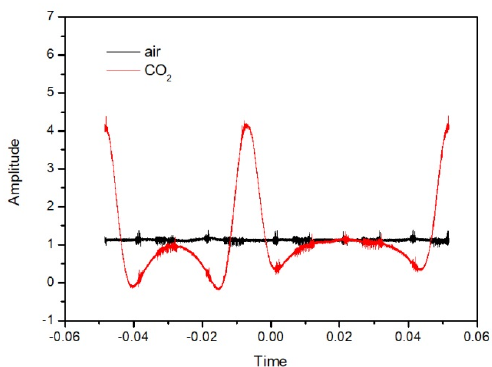
Figure 3. Second harmonic signal of spectroscopic high throughput blood culture apparatus.